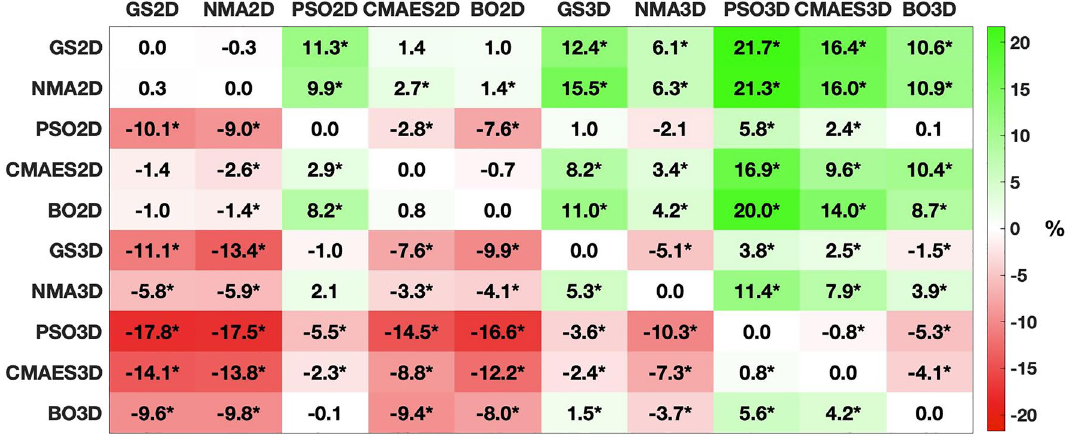
Figure 5. Comparison of the considered methods with regard to the detected goodness-of-fit values across all subjects. For every optimization technique and subject, the highest goodness-of-fit value is considered. The medians of the relative differences between any two methods are indicated in the cells which are highlighted in color. To this end, the goodness-of-fit values of the approaches listed on the vertical axis (lines) are subtracted from those of the methods indicated on the horizontal axis (columns). Results that proved statistically significant in the Wilcoxon signed-rank test are marked with an asterisk (the significance level of 5%, p < 0.05, has been Bonferroni-corrected for multiple comparisons). The figure was created with MATLAB R2018a (www. mathw orks.